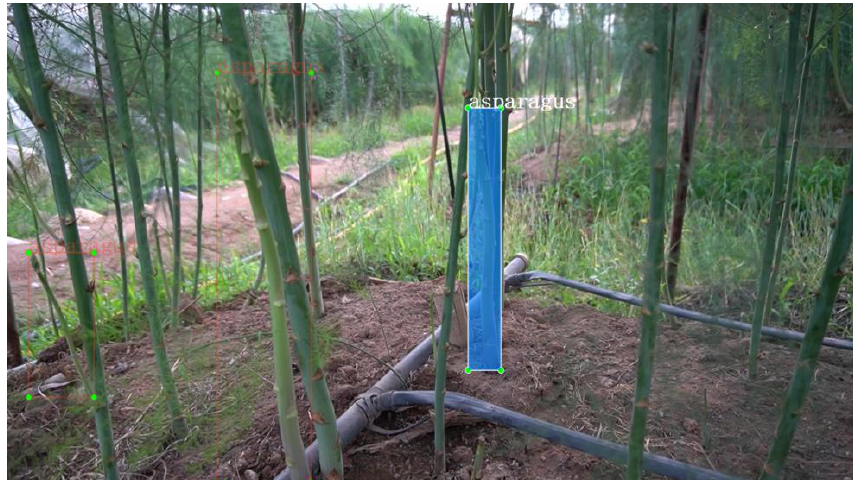
Figure 3. Labeling of the image.